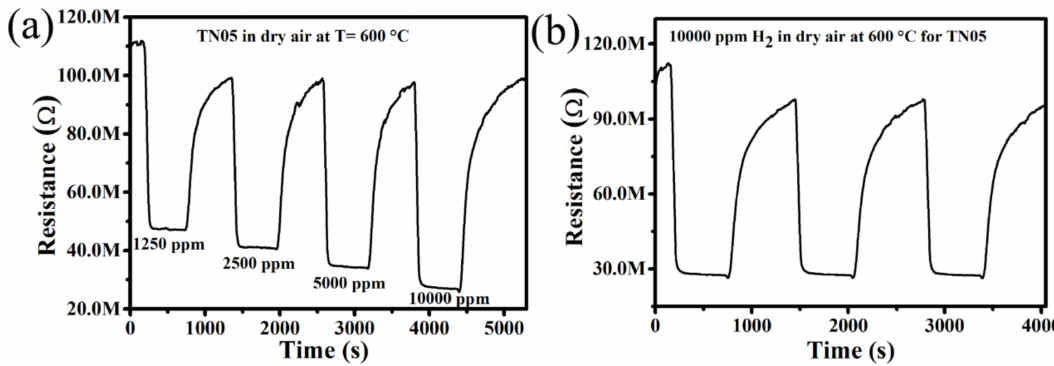
Figure 8. Dynamic response of gas sensors based on 0.5% Ni-doped TiO 2 to ( a ) various concentrations of H 2 and ( b ) 10,000 ppm H 2 at 600 ◦